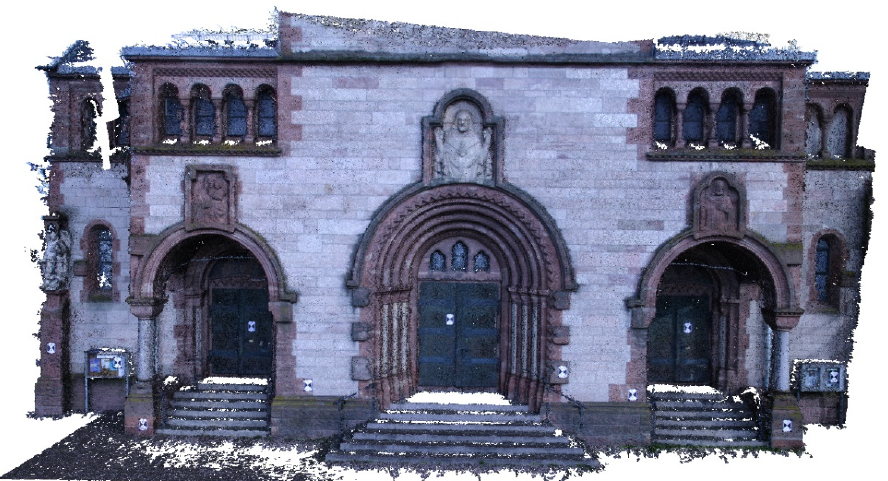
Figure 18. Dense point clouds of Herz-Jesu-P25 sequence.